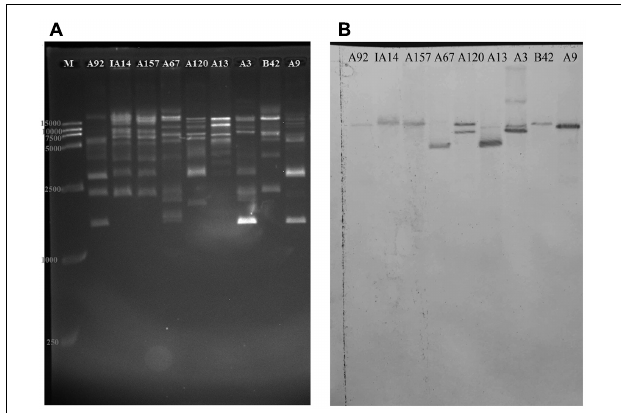
FIGURE 5 | Determination of the fosB gene copy number by enzyme Bsa I digestion binding hybridization. Shown is (A) agarose (1%) gel electrophoresis in 0.5 × Tris-boric acid-EDTA buffer of Bsa I-digested plasmids from the transconjugants of A92, IA14, A157, A67, A120, A13, A3, B42, and A9 stained with Gel Red and visualized under UV light, and (B) Southern blot hybridization with the fosB -latter probe. M is a 15-kb size DNA marker.